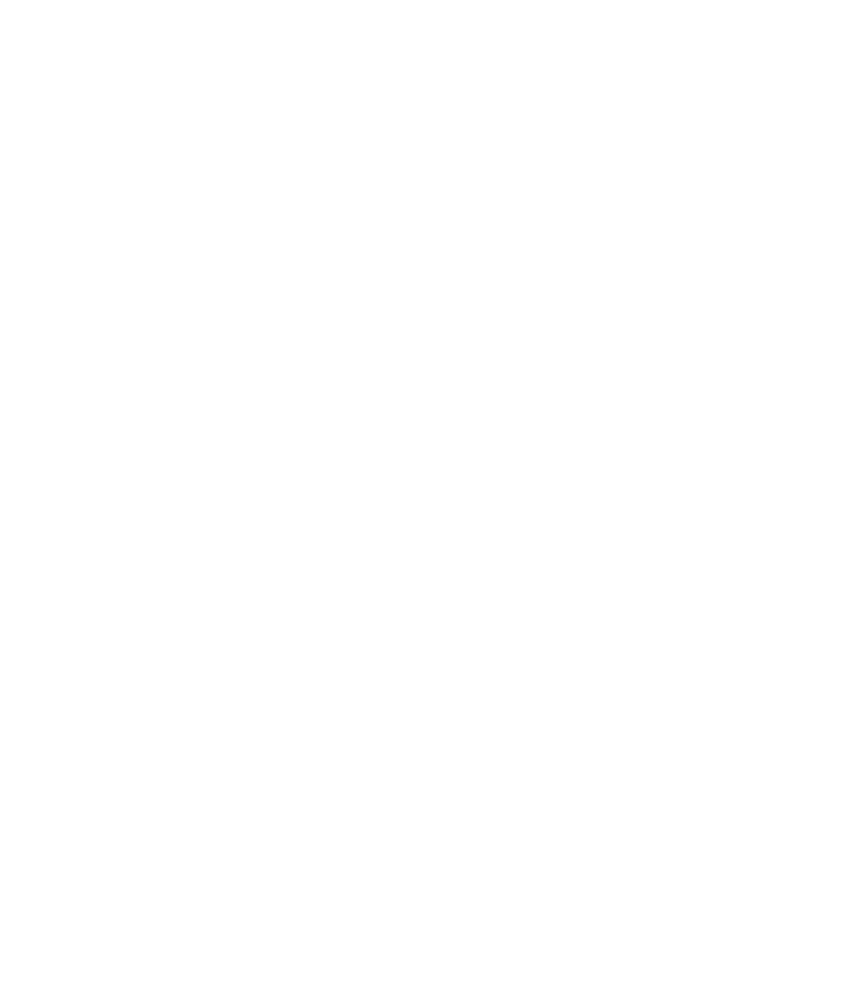
Frontiers in Physics |